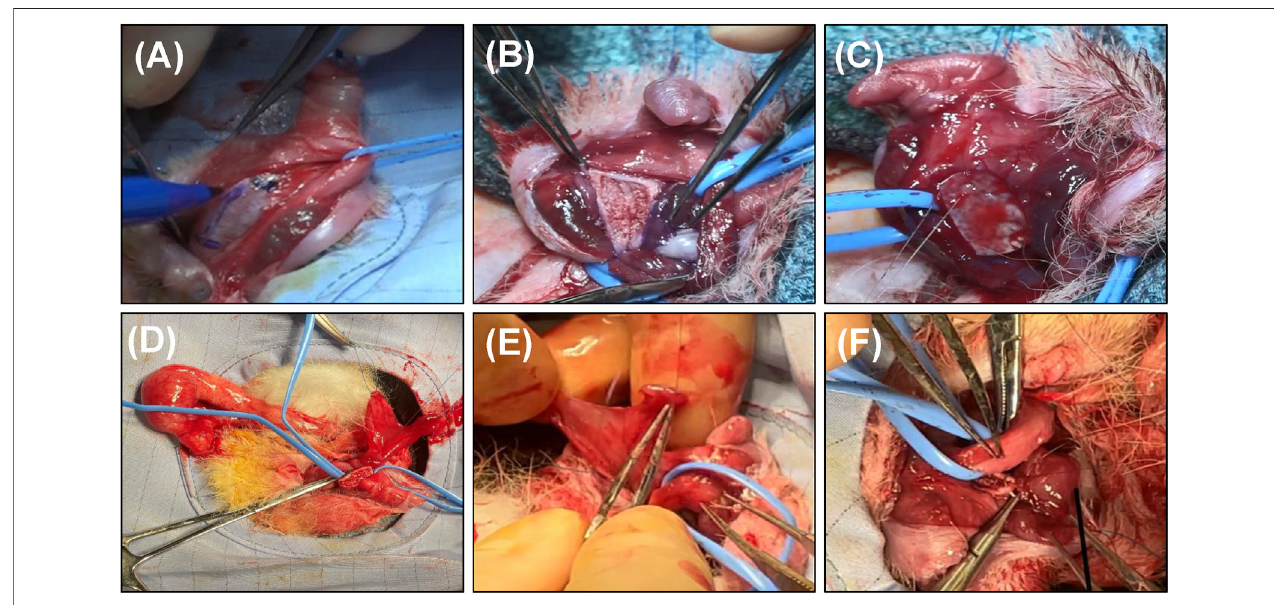
FIGURE 1 | Rabbit corporoplasty model. Overview of surgical reconstruction stages with BLSF grafts (A – C) and TV fl aps (D – F) . (A) The penile skin was degloved and the urethra dissected and lateralized from the cavernous bodies to expose the target implantation area. (B) Creation of tunica albuginea defect (10 × 7 mm). (C) BLSF graft anastomosed into defect. (D) Dissection of the TV fl ap from the anterior surface of the right testes with preservation of the vascular supply followed by transposition through the scrotum and penile skin. (E) The distal end of the TV fl ap was sutured horizontally on its visceral surface to create a patch for tunica albuginea repair. (F) Surgical integration of the TV fl ap into the defect area. BLSF, bi-layer silk fi broin scaffold; TV, tunica vaginalis.